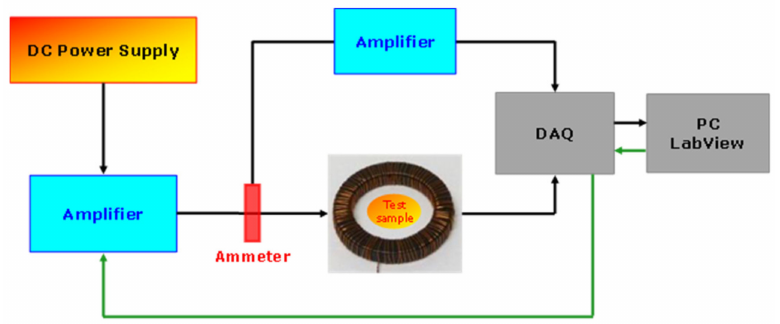
Figure 5. Magnetic characterization system setup with Lab View platform (DAQ—Data Acquisition).